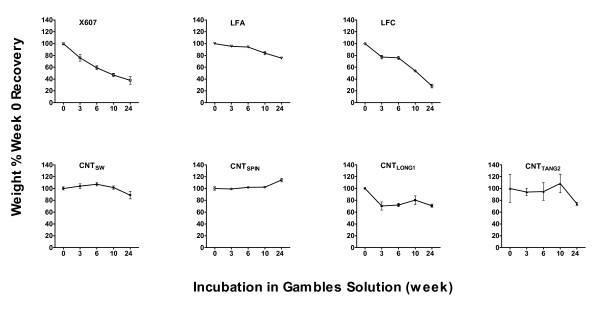
Durabilities of CNT samples and controls in simulated biological fluid. The weights of quadruplicate samples of glass wool fibre (X607), asbestos fibres (LFA, LFC) and CNT test samples (CNTSW, CNTSPIN, CNTLONG1 and CNTTANG2), recovered from Gambles solution following incubation for various times are expressed relative to the weight of sample recovered at 0 weeks.